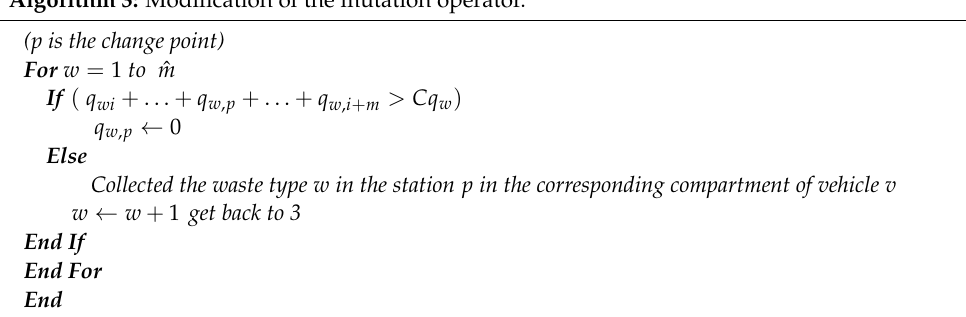
Table 4. Comparison of the results found by HGA and CPLEX.